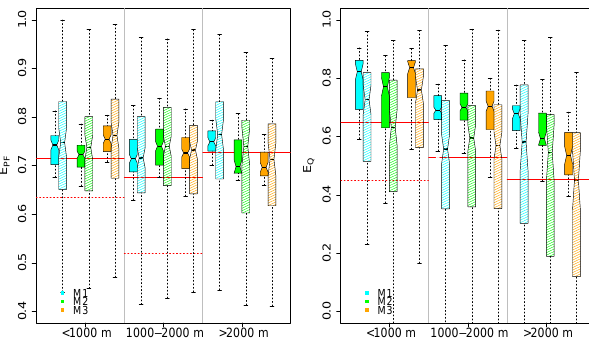
Figure 5. Results of the leave-one-out approach. E PF (left panel) and E Q (right panel) for each elevation class and snowmelt model. For the individual elevation classes and melt models, the left box plots (darker colors) show the results for the calibration period, and the right box plots (lighter colors) show the results for the valida- tion period. The whisker boxes represent the median (center line), the interquartile range (25th–75th percentile; box outline) and high- est/lowest performance within the interquartile range ( ± 1.5 times of the interquartile range; whiskers). The benchmark performance is denoted by a solid red line (upper benchmark) and a dashed red line (lower benchmark), and the latter only displayed if within the range of the axis